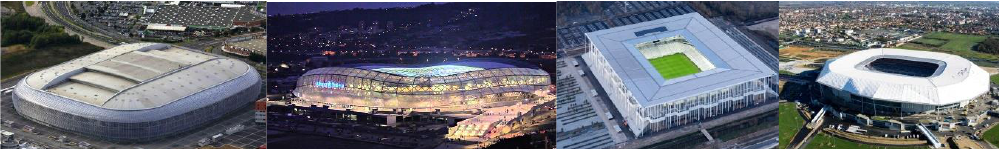
Figure 1. Overview of the arenas built for Euro 2016 in France. From the left to right: Pierre-Mauroy Stadium (Lille), Allianz-Riviera (Nice), Noveau Stade de Bordeaux (Bordeaux), and Parc Olympique Lyonnais (Lyon) [43 – 46].